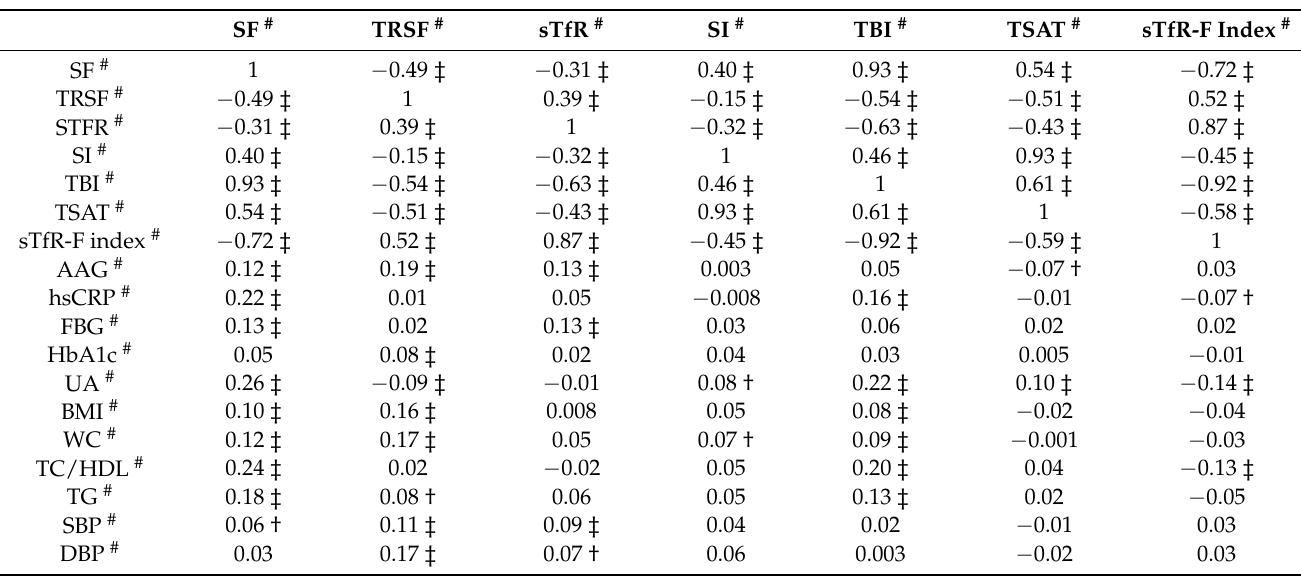
Table 3. Partial Pearson coefficients (adjusted for age, education, physical activity, district, and city type) between markers of iron metabolism and risk factors of T2DM in the overall study sample ( n =